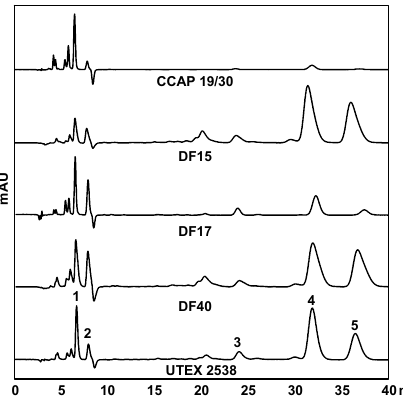
Figure 5. HPLC chromatograms of MTBE/ethanol extracts of the five Dunaliella strains cultivated under 1500 µmol·m − 2 ·s − 1 . The major peaks shown are: (1) lutein, (2) zeaxanthin, (3) all-trans α -carotene, (4) all-trans β -carotene and (5) 9-cis β -carotene.